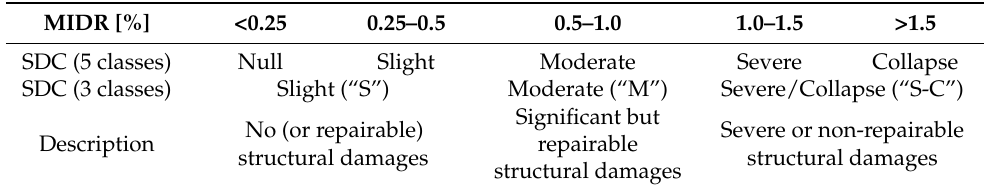
Table 3. Definition of the SDC (DS) using the MIDR as EDP.